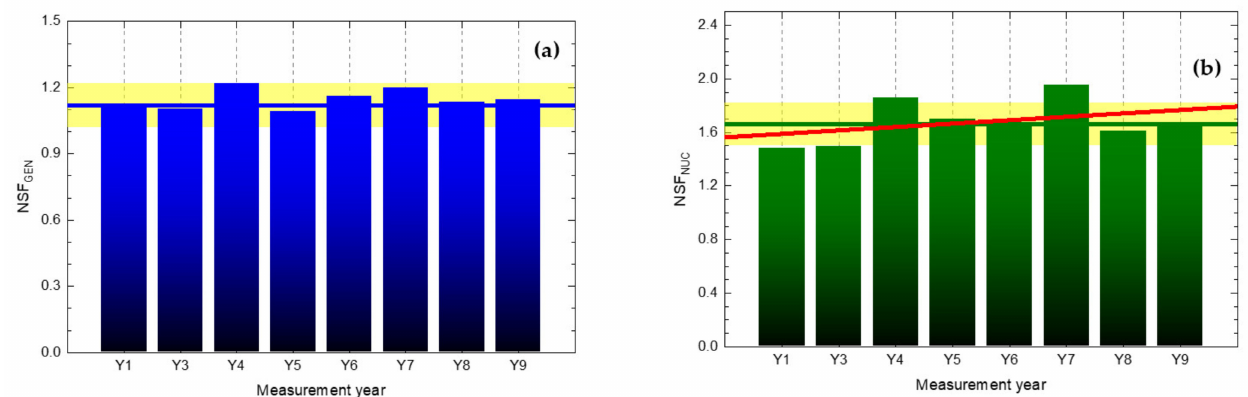
Figure 4. Annual means of NSF GEN ( a ) and NSF NUC ( b ) for the city center separately for the 8 measurement years. The solid line and yellow band represent the overall mean and its standard deviation. The red line was obtained by fitting a linear line of the annual data and indicates a possible increasing tendency.